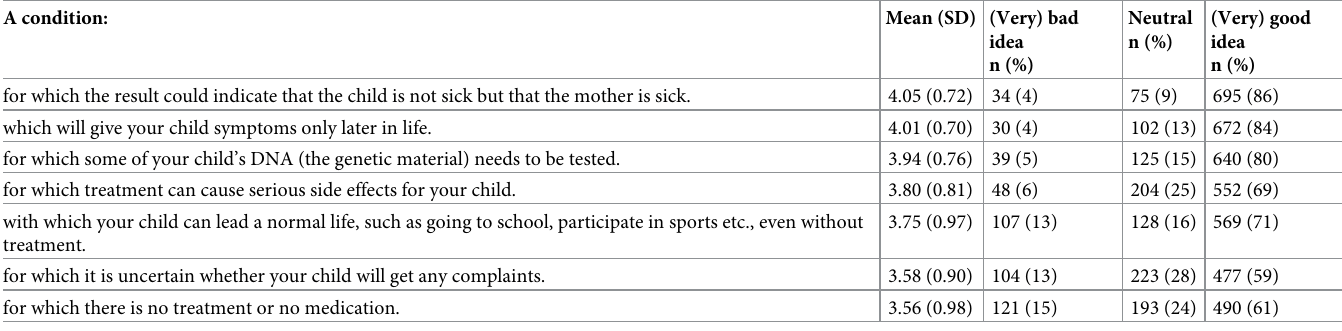
Table 5. Degree of acceptance of adding a specific condition to the heel prick